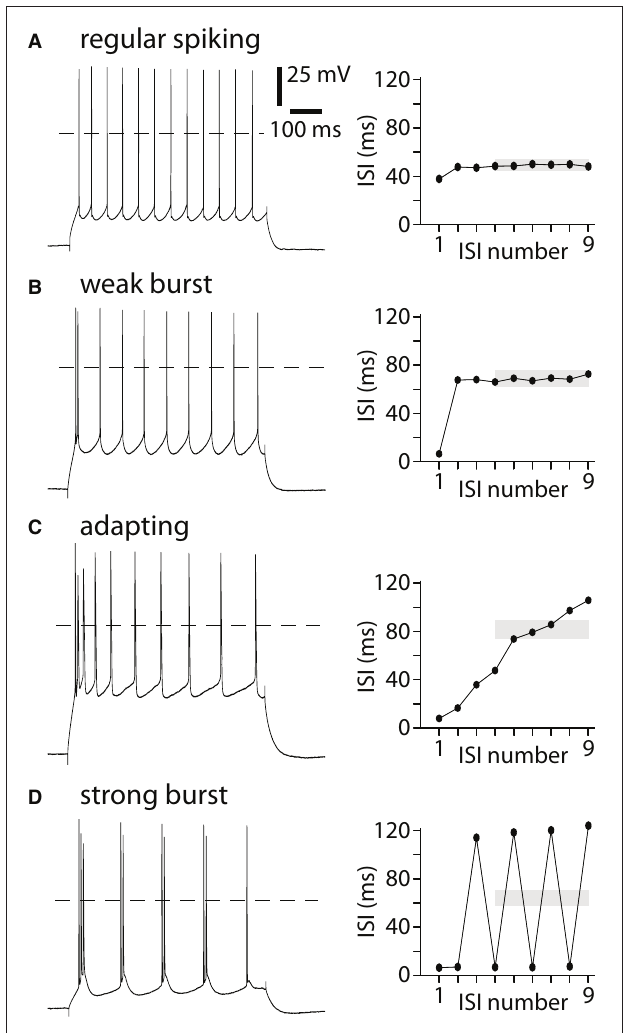
FIGURE 1 | Examples of four spiking patterns of cortical pyramidal neurons. Example spiking patterns and ISIs for each of the four firing patters in our classification system: regular spiking (A) , weak bursting (B) , adapting (C) , strong bursting (D) . Spiking was evoked with a 600ms constant current injection via the somatic recording pipette. Dashed lines indicate 0mV. Spiking patterns are arranged from most regular (A) to least regular (D) . Currents were 300pA ( A and B ), 325pA (C) and 150pA (D) . Gray boxes are drawn from ISI 4 to ISI 9. The upper and lower boundaries of the boxes are at 110% and 90% of the mean of ISIs